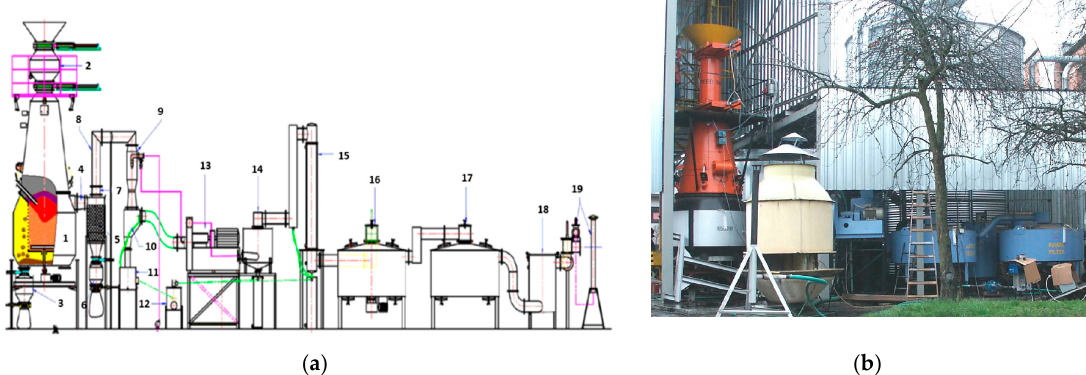
Figure 2. ( a ) Scheme of the ANKUR WBG-400 based gasification system with pre-treatment for